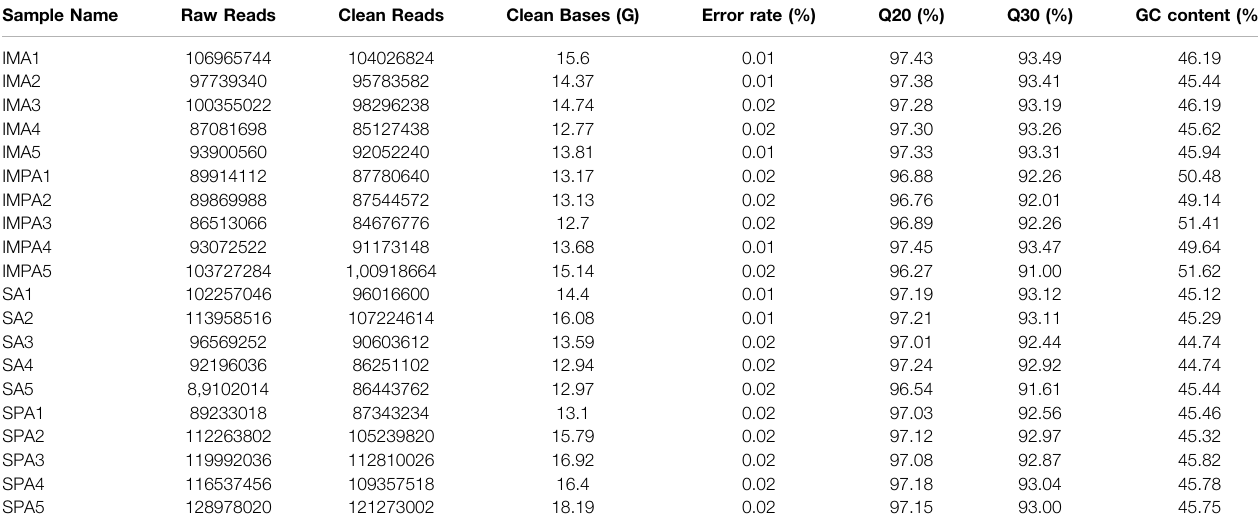
TABLE 2 | Output statistics of the sequencing reads for each sample.